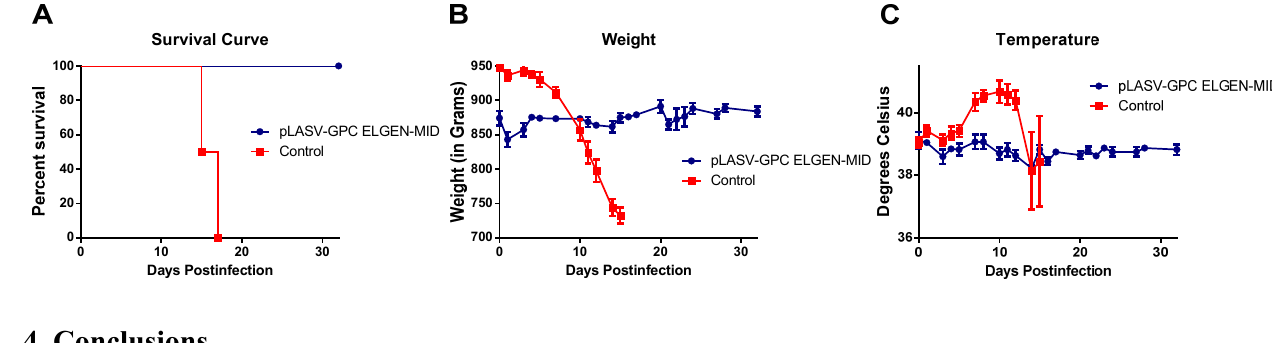
Figure 5. Outcome of backchallenge experiment. ( A ) Survival curve; ( B ) Average weights postchallenge; and ( C ) Average temperatures post-challenge for animals enrolled in the backchallenge